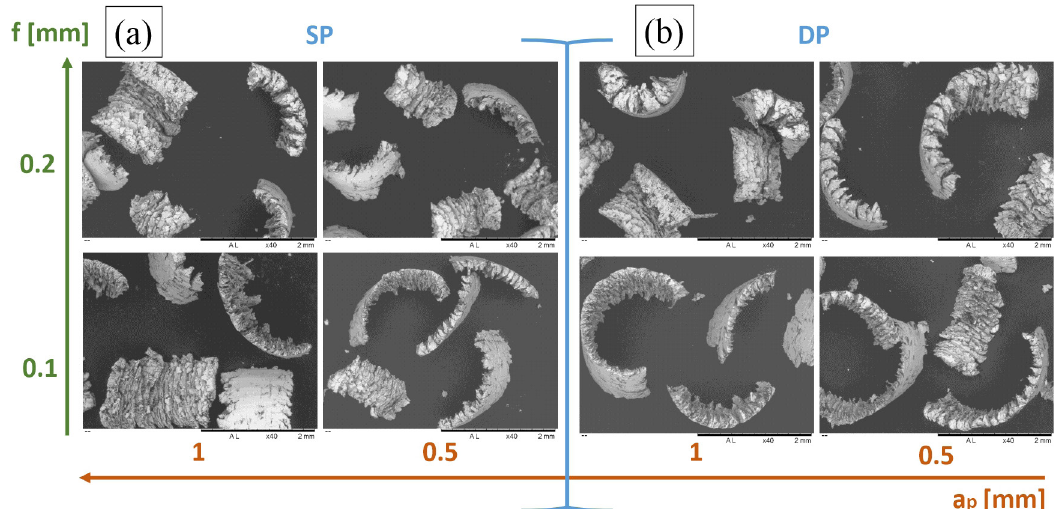
= 200 m/min for the (a) SP and (b) DP c